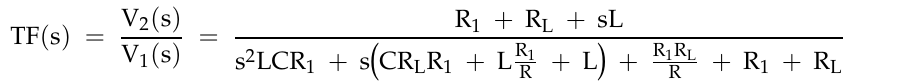
Figure 3. Equivalent circuit diagram of the piezoelectric stack (C and R) and lightning impulse attenuator, L, R L and R 1 .